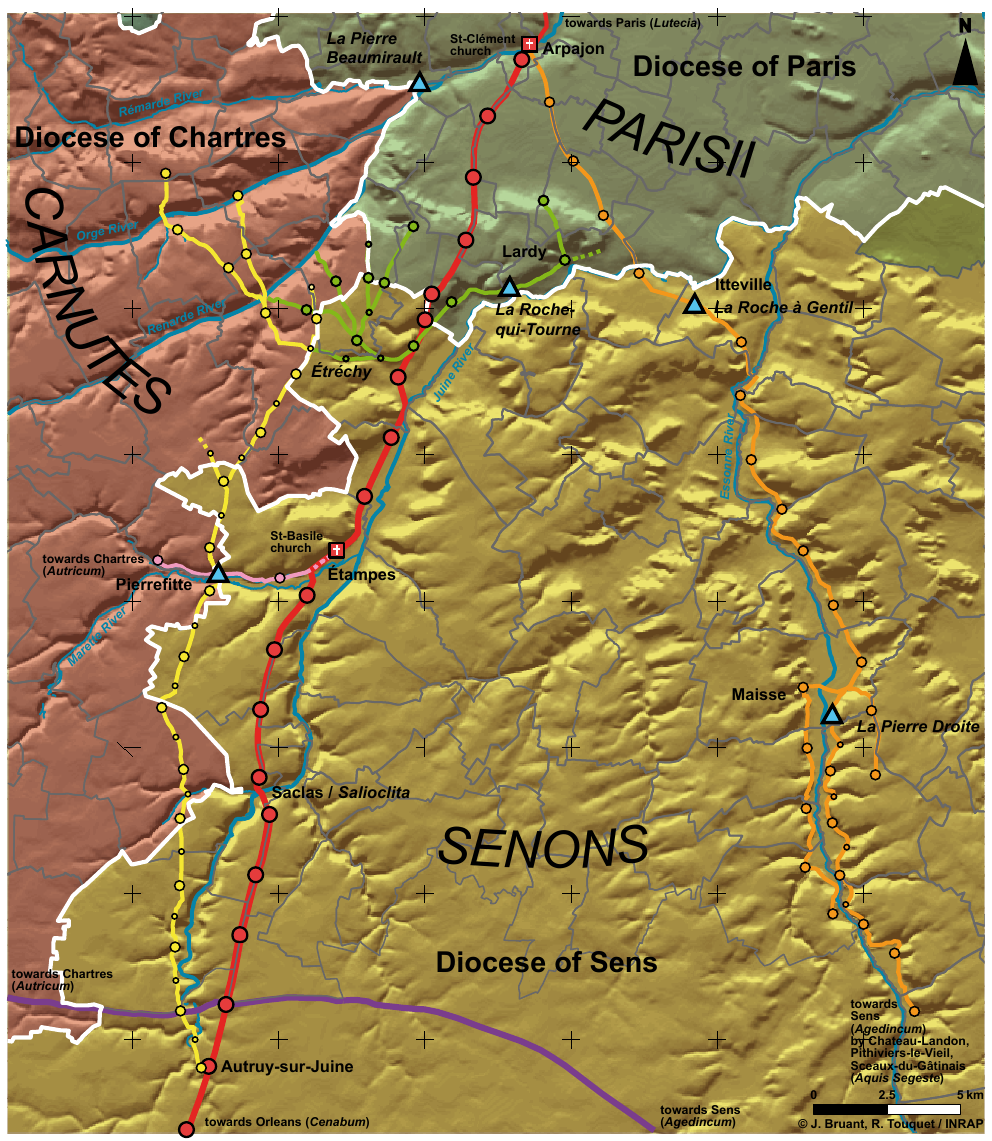
Fig. 9 - The map of the study zone as generated from the virtual testing lab in the south of Essonne department. The relationship between the positions of certain megaliths includes Figure 9. The map of the study area as generated from the virtual testing lab opened in the south of the Essonne department those of presumed leaguestones every 2222 m and dioceses / civitates limits. showing the relationship between the positions of certain megaliths, one of the supposed leaguestones every 2222 m and the dioceses/ civitates (?) limits. © J. Bruant, R.